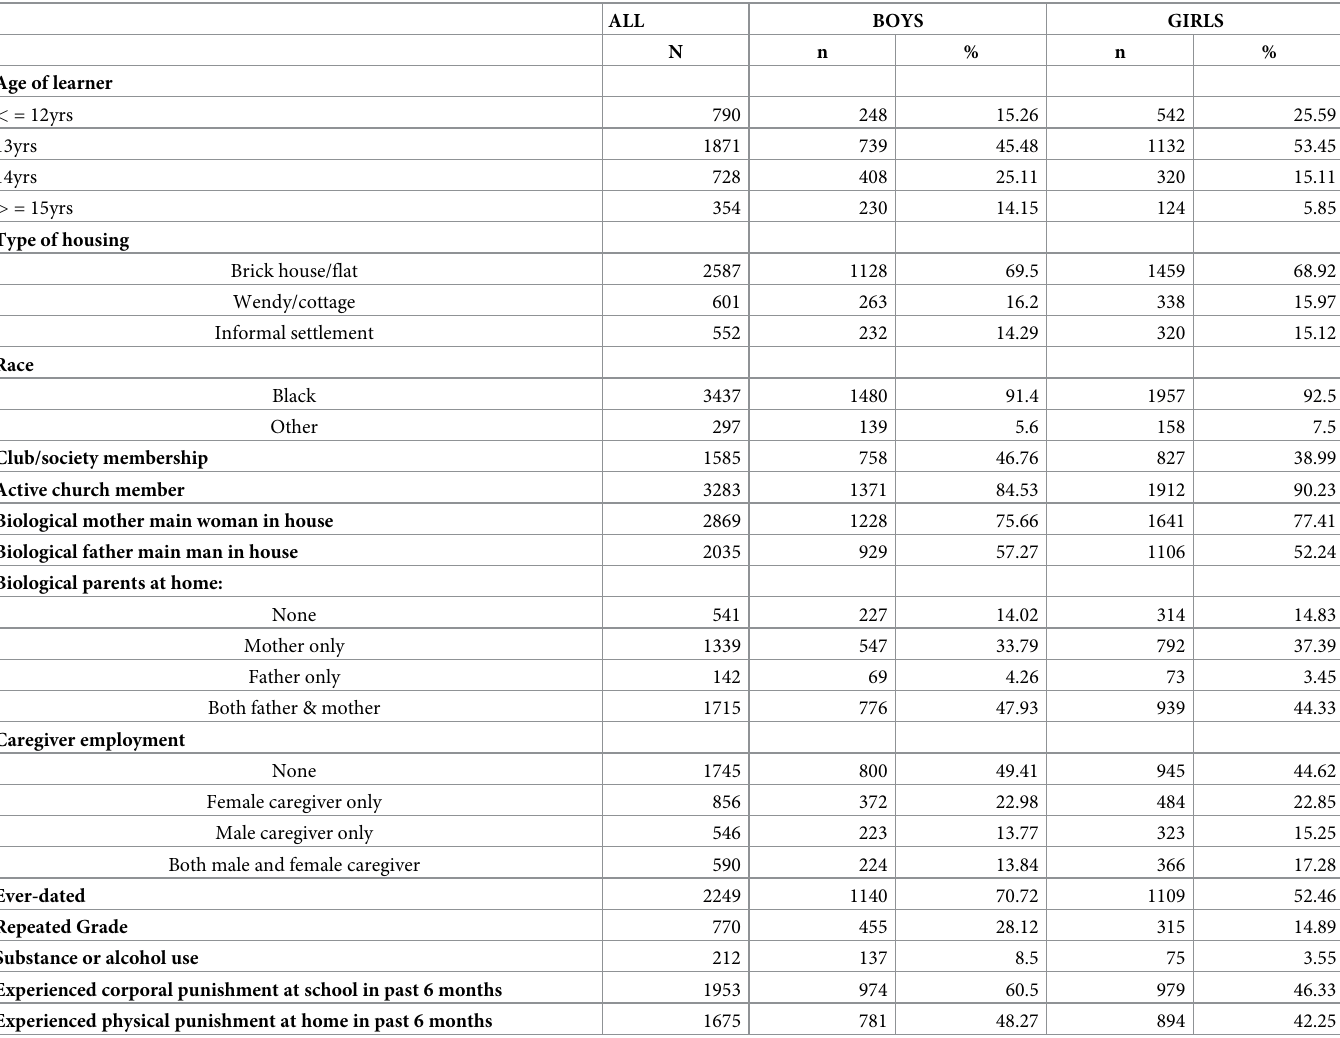
Table 2. Sample characteristics and school corporal punishment experience by sex of